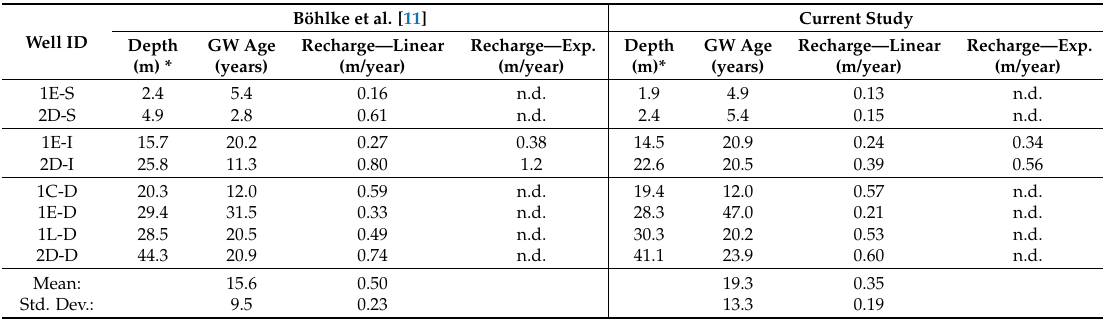
Table 1. Apparent groundwater (GW) age from both 1998 and 2016 based on 3 H/ 3 He age estimates. Recharge rates were estimated with a linear equation in all cases, and with an exponential (Exp.) equation for intermediate